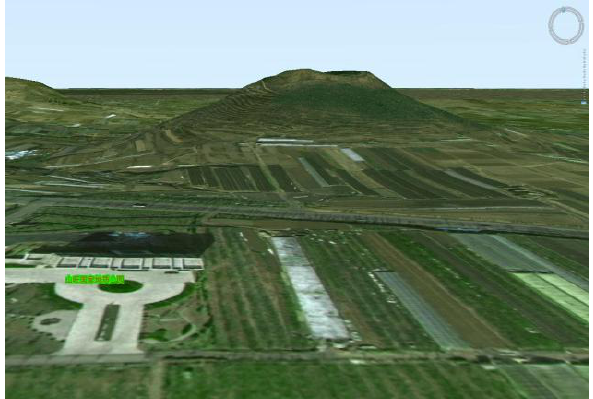
Figure 11. Chamashan ancient volcanic cone